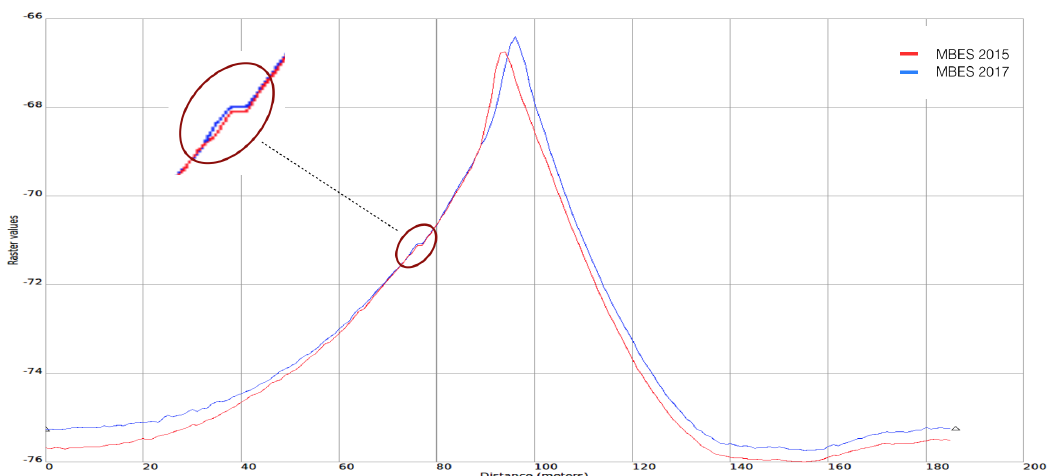
Figure 34. Vertical profile for one of the sand dunes from two different cruises, data collected in 2015 (red) and 2017 (blue). From the zoomed details, on the upper half of the stoss slope, a horizontal step is visible that matches almost perfectly between the two datasets.